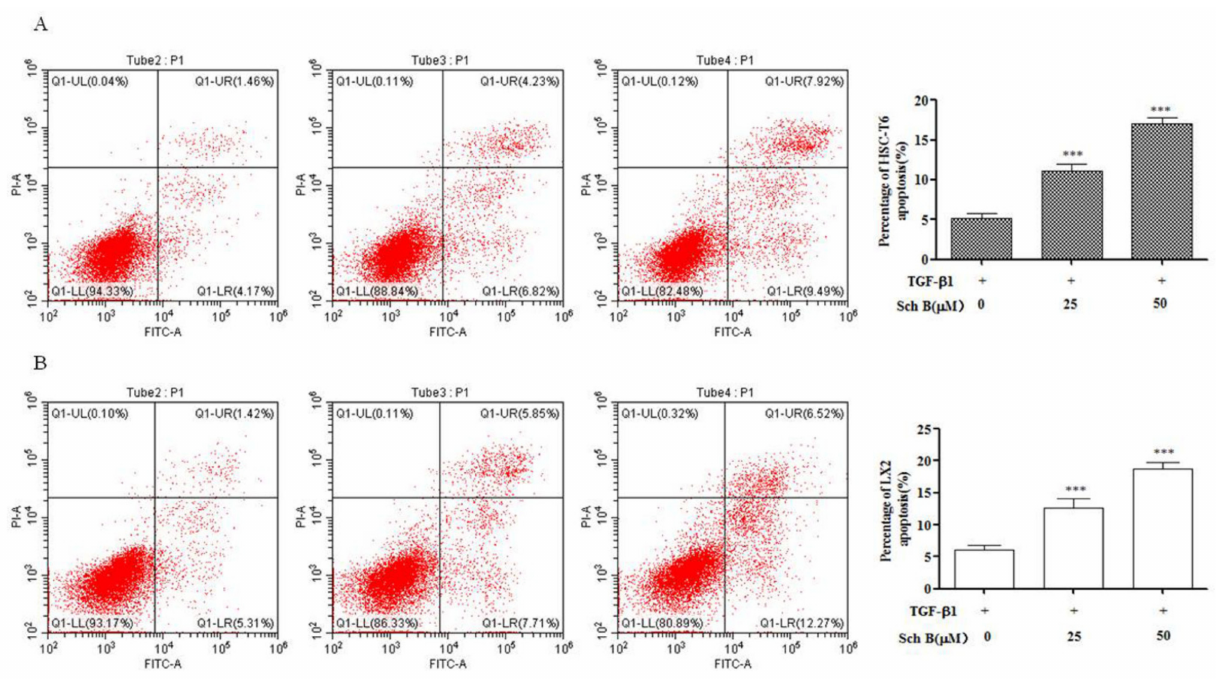
Figure 4. Sch B induced HSCs apoptosis. ( A ) HSC-T6 cells were treated with 0, 25 or 50 µ M Sch B for 24 h, ( B ) LX-2 cells were treated with 0, 25 or 50 µ M Sch B for 24 h and apoptosis was assessed by flow cytometry. The results shown are means ± SD, *** p < 0.001 compared with the TGF- β 1